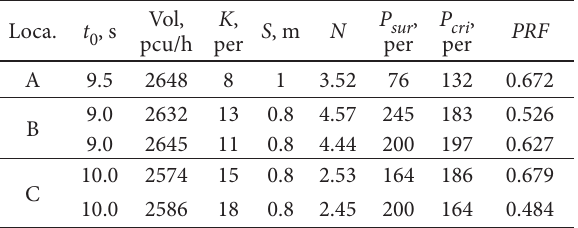
Table 6. PRF determination along Hongqi Str. segment Loca.